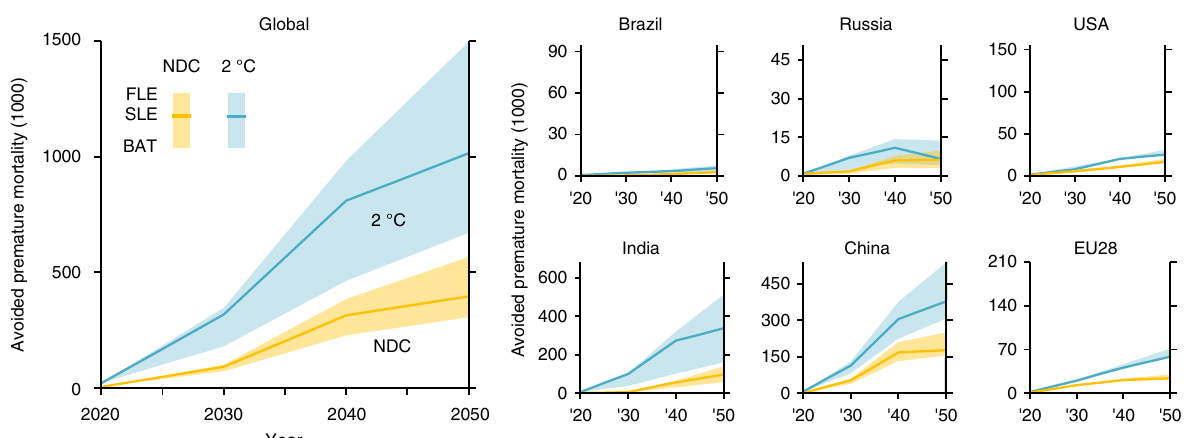
Fig. 4 Avoided premature mortality due to lower PM 2.5 concentration and ozone mixing ratio implied by climate change mitigation policies. Results shown are relative to the corresponding climate policy Reference case and use non-linear exposure-response functions based on Global Burden of Disease 2015 25 , with the range encompassing estimates with Fixed Legislation (FLE), Stringent Legislation (SLE), and Best Available Technologies (BAT) air quality scenarios. In addition to global results, the fi gure shows avoided premature mortality (in thousands) for six regions. To display the absolute numbers in a way that makes the regional fi gures comparable against each other, the range of the vertical axes is scaled to 0.04% of the region-speci fi c population in